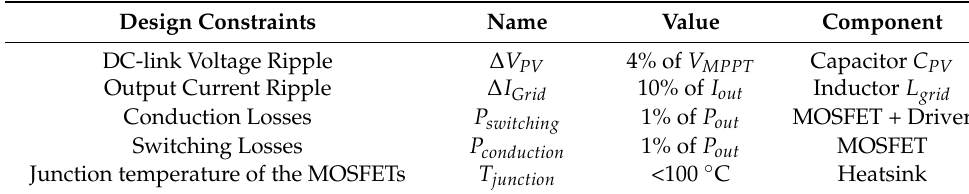
Table 1. Design constraints for both